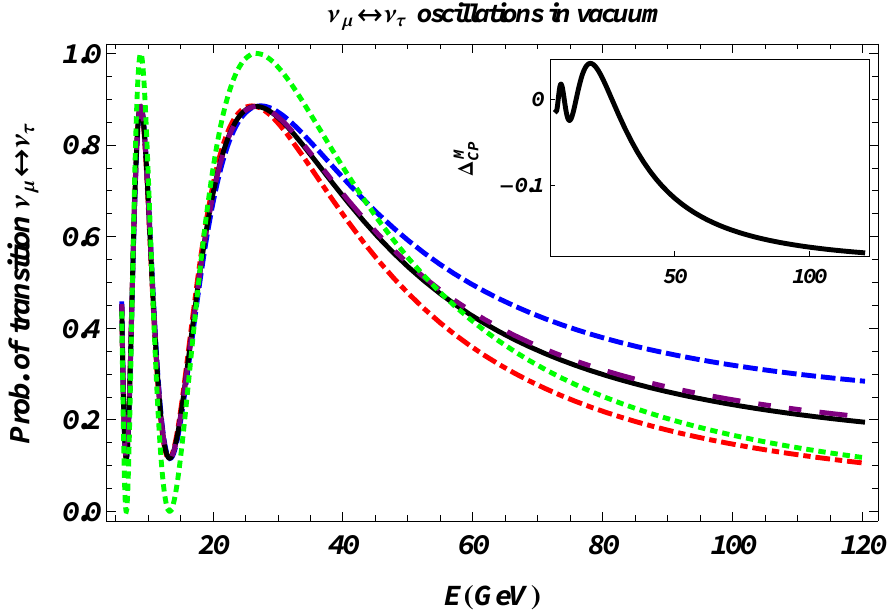
Figure 3. (Color online) Plots of the oscillation formulas P ν P ν (the blue dashed line) for Majorana neutrinos and for Dirac neutrinos ( φ = 0, the black τ → ν µ line), as a function of the energy E , in vacuum. The purple, dashed line is obtained for α = 0. = P In this case P ν ν µ → ν τ and one has the same formula for Majorana and for Dirac neutrinos. µ → ν τ The Pontecorvo formula is represented by the green dotted line. We consider the following values of the parameters: φ = π , z = 1.3 × 10 4 km, sin 2 θ 23 = 0.51, ∆ m 2 4 γ 3 = 7.9 × 10 − 24 GeV, α = 3.8 × 10 − 24 GeV. Picture in the inset: plot of ∆ M of the parameters used in the main